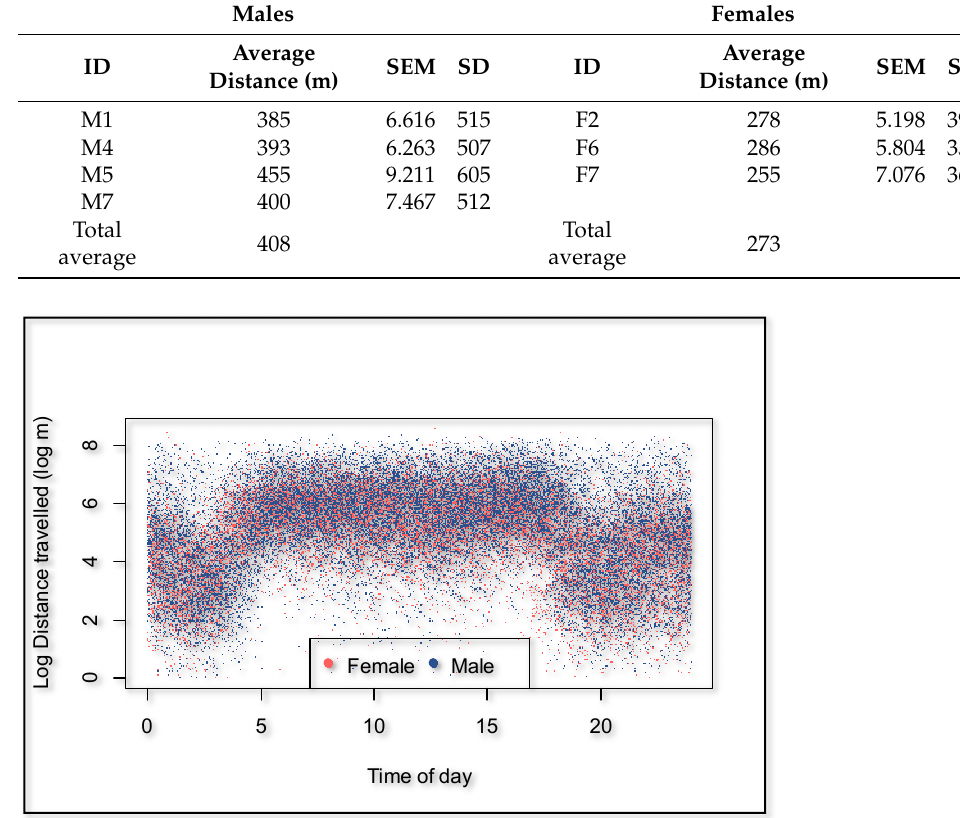
Figure 2. Distances traveled for males and females per hour over 24 h.